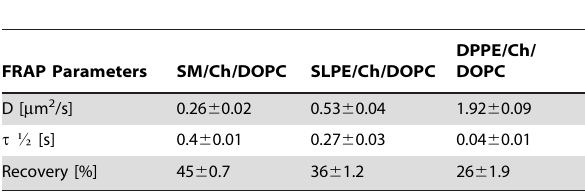
Table 3. FRAP parameters of NBD-cholesterol in SM-/SLPE-/ DPPE-based